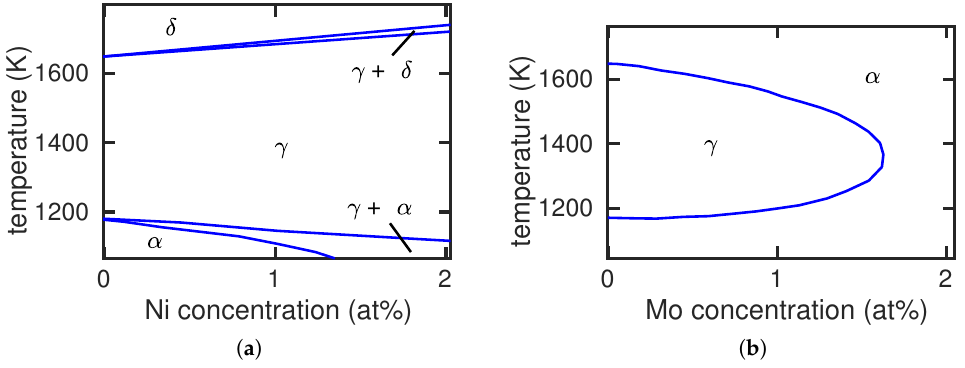
Figure 1. Fe-Ni ( a ) and Fe-Mo ( b ) phase diagrams exemplifying the case of γ and α stabilizing alloying elements, respectively. Experimental data from